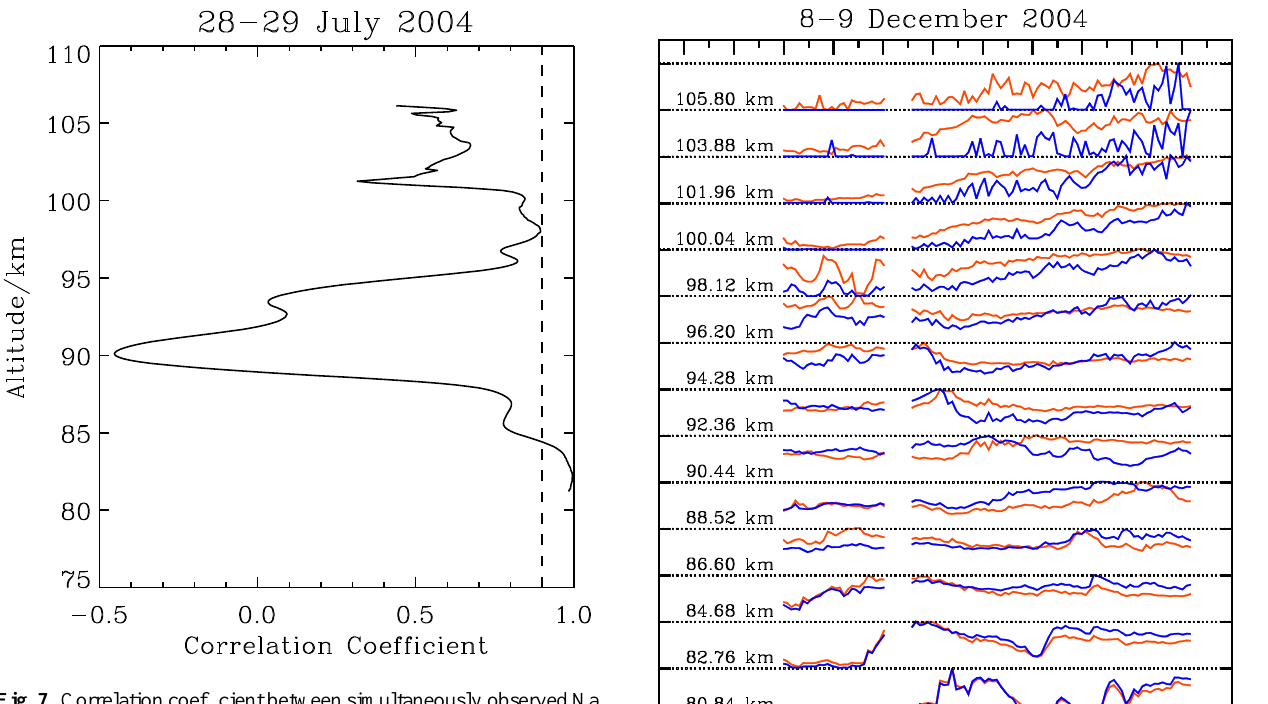
Fig. 7. Correlation coefficient between simultaneously observed Na and Fe densities versus altitude on the night of 28–29 July 2004.